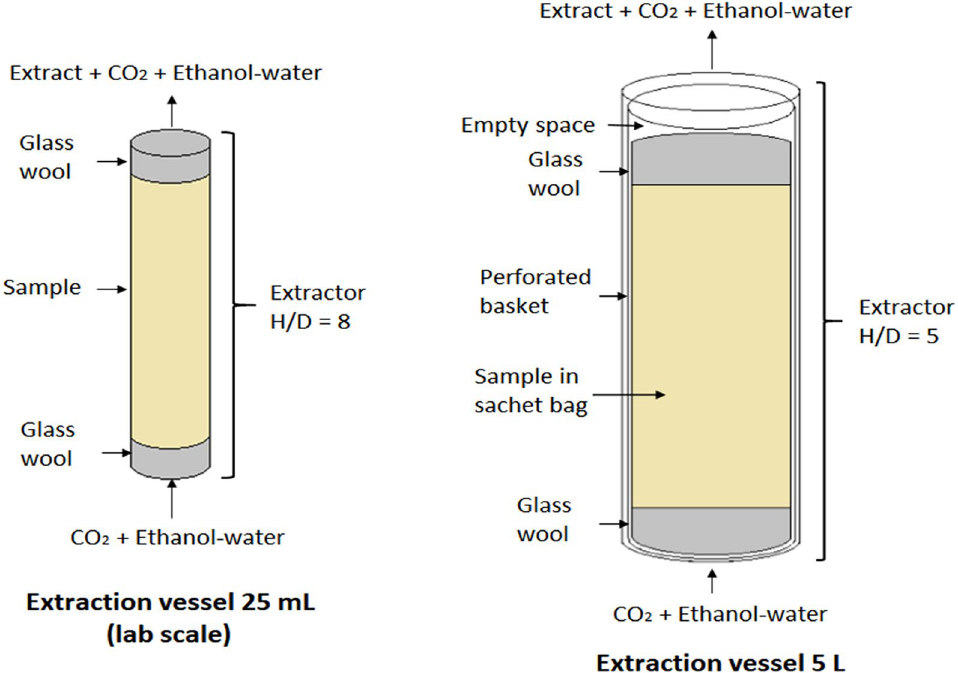
Figure 2. Internal configuration of extraction vessels at different SFE scales. H/D: ratio of height to diameter of the vessel, SS: stainless